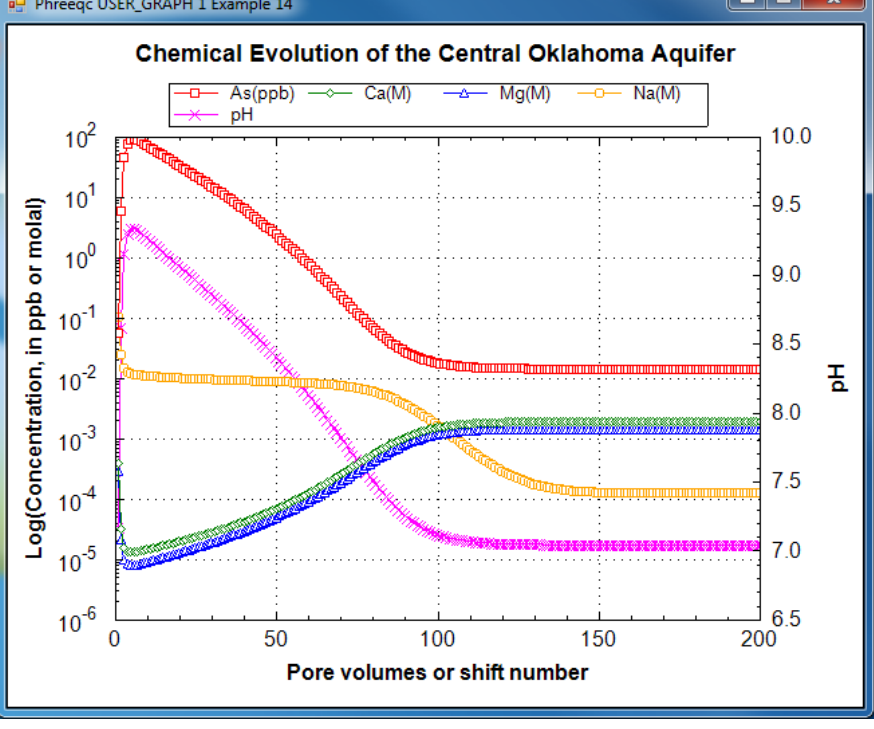
Figure 15. Results of transport simulation of the chemical evolution of groundwater due to calcium magnesium bicarbonate water inflow to an aquifer initially containing a brine, calcite and dolomite, a cation exchanger, and a surface that complexes